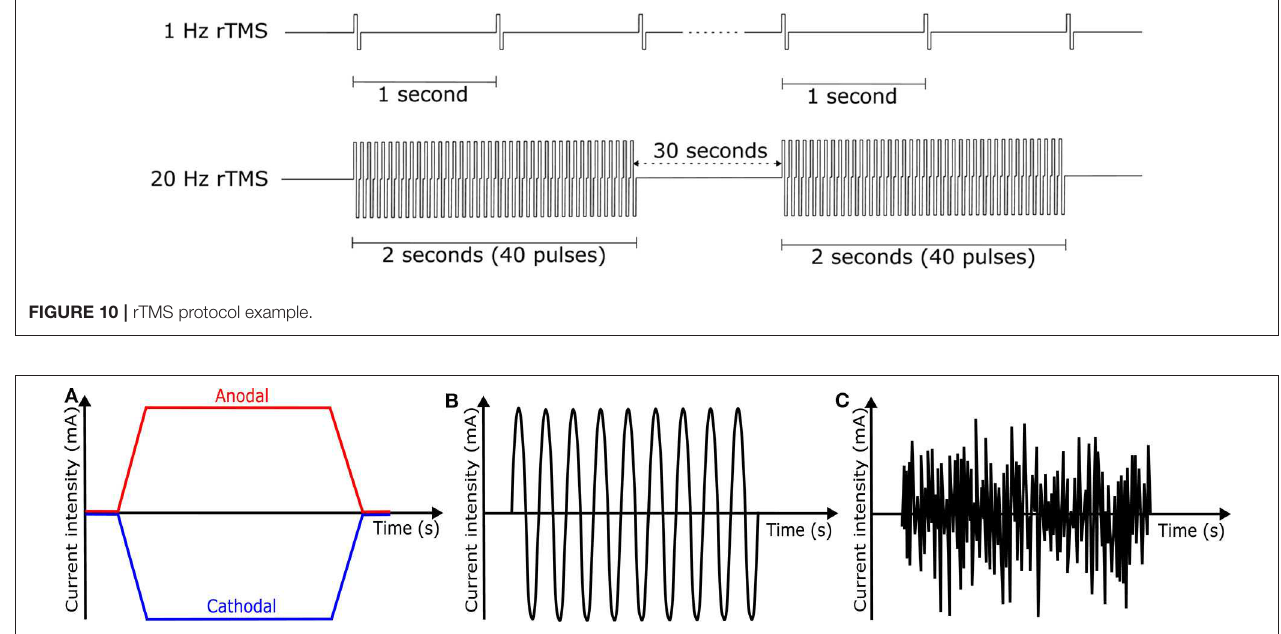
FIGURE 11 | Waveforms of different tES techniques. (A) tDCS waveform (B) tACS waveform (C) tRNS